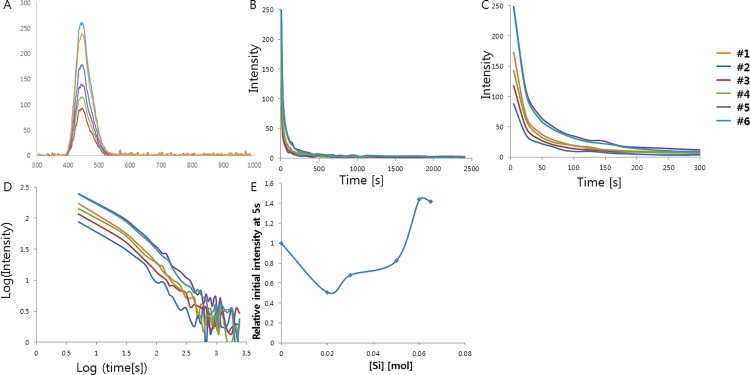
(A) Emission spectrum of CaAl2O4:Eu2+, Nd3+ crystals depending on Si4+ concentration. (B) Decay curves depending on Si4+ concentration. (C) Magnified views of the graph in (B). (D) Decay curves in log scale depending on Si4+ concentration. (E) Relative initial intensity measured at 5s (relative values where the value of control sample #1 is 1.0) depending on Si4+ concentration.